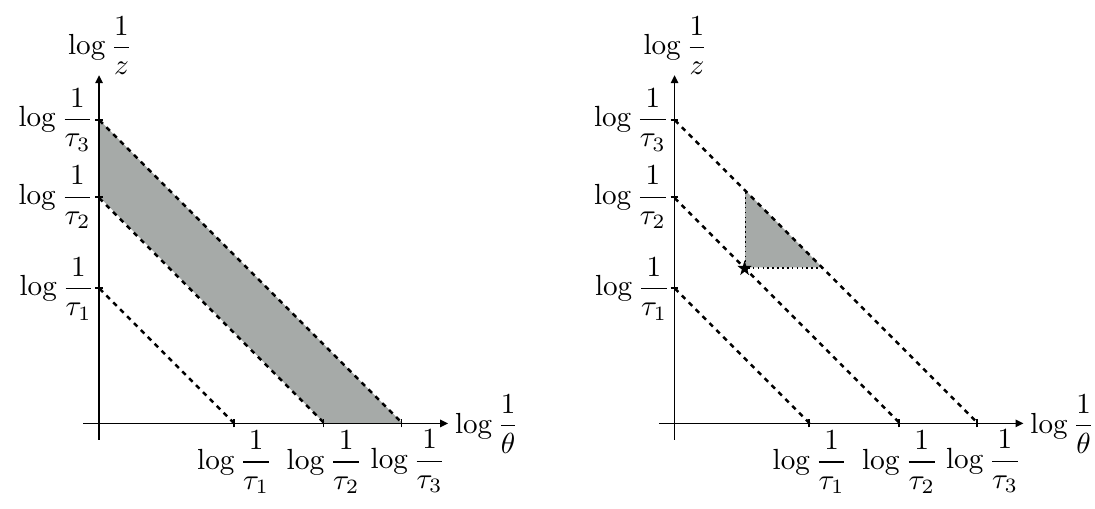
Figure 4. Illustrations of the two of the forbidden regions (grayed) for gluon emission that sets the value of (cid:28) 3 , given a values of (cid:28) 1 and (cid:28) 2 . The location of the emission that sets the value of (cid:28) 2 in the Lund plane is illustrated by the star. On the left is the forbidden region if the gluon is emitted o(cid:11) of the initiating quark; the only restriction on the gluon is that it must set (cid:28) 3 < (cid:28) 2 . On the right is the forbidden region if the gluon is emitted o(cid:11) of the gluon that sets the value of (cid:28) 2 ; it must be both at smaller angle and have smaller energy than the (cid:12)rst emitted